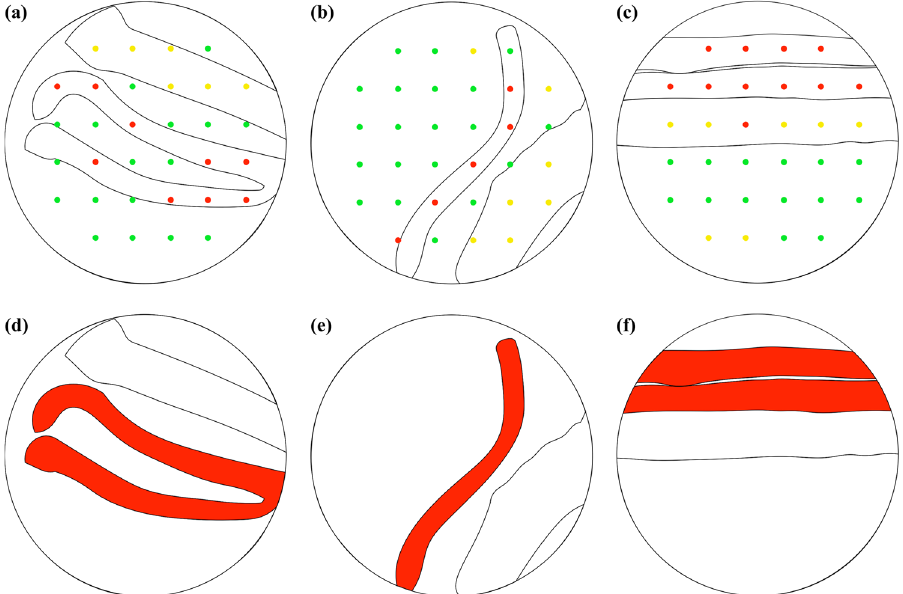
Figure 5. Visualizing the nerve bundles by morphology-highlighted images, the tissue type maps, and the nerve detection criterion on the N N / N total . ( a – c ) The overlay of morphology-highlighted images, and tissue type maps of samples shown in Fig. 3. At red, yellow, and green points, tissues are discriminated as peripheral nerve, connective, and skeletal muscle tissues, respectively. ( d – f ) The nerve bundles highlighted in red according to the nerve detection criterion of N N /N total = or >